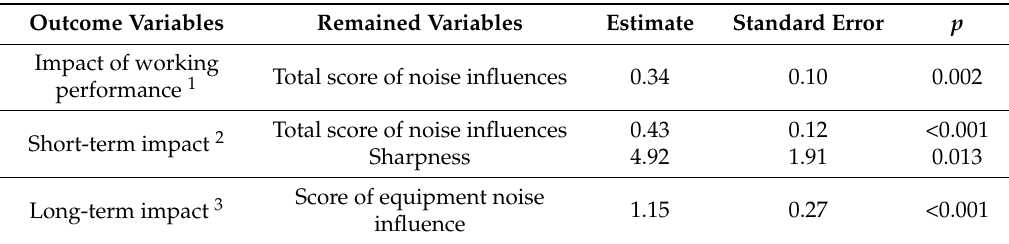
Table 3. Multiple linear regressions of the scores of the negative impacts on the dental professionals from the environmental changes.